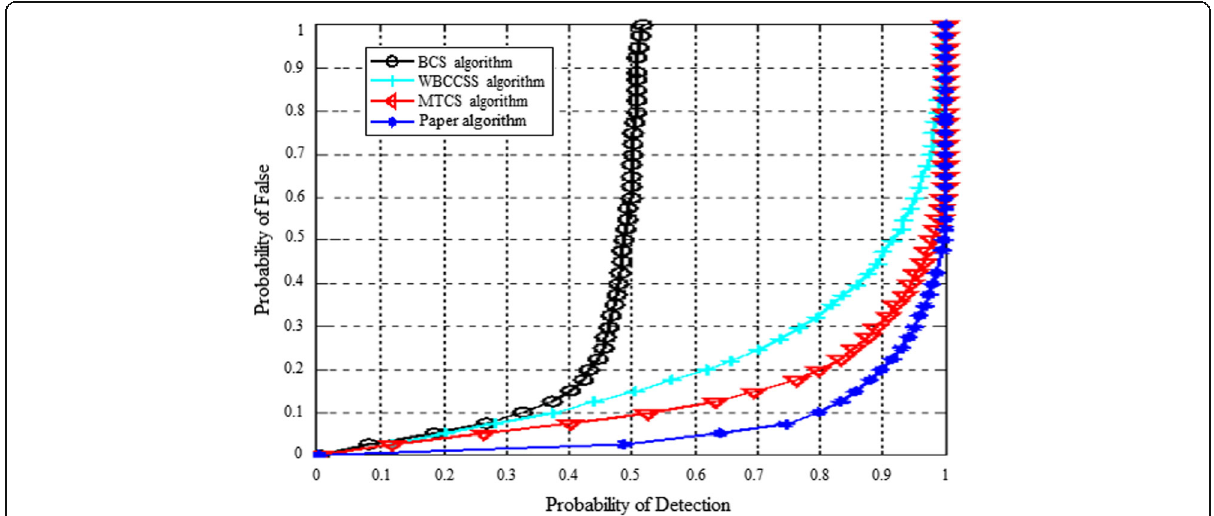
Fig. 5 Four algorithms ’ performance comparison under the same SNR. Figure 5 indicates the four algorithms under the same SNR performance simulation curve comparison as follows: when the false alarm probability is 0.1, the detection probabilities of BCS, WBCCSS, MTCS, and paper algorithm were 0.3328, 0.3815, 0.5246, and 0.7925, so the joint spectrum signal detection algorithm compared to BCS, WBCCSS, MTCS algorithm, and spectrum detection has better performance, and from the simulation curve, it can be found using the Dirichlet process that this can be achieved within each group shared with shearing section at parameters. The process fully considers the perception of the temporal correlation of data compression. The performance of the algorithm is obviously better than BCS, WBCCSS, and algorithm utilizes the information of non-parametric grouping mechanism. The multi-layer Bayesian model